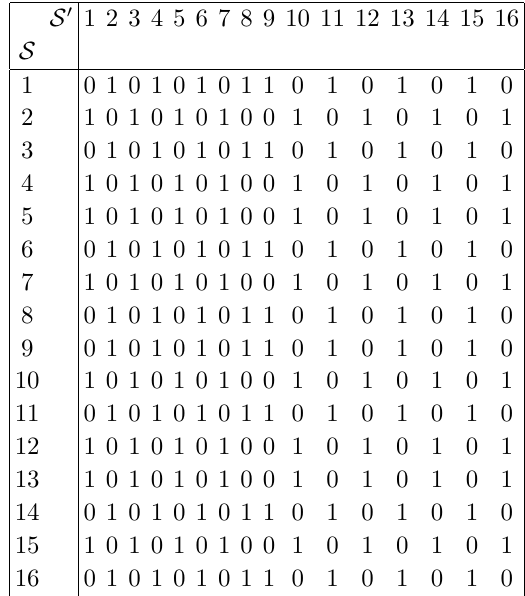
Table 26 . Gadget values for P